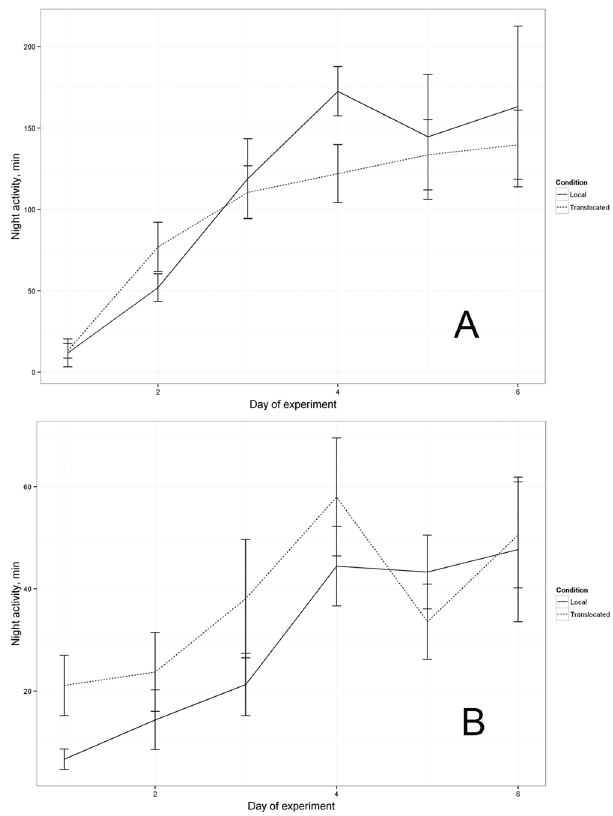
Figure 1. Development of nocturnal activity in local (solid line) vs. translocated (dotted line) birds for indoor ( A ) and outdoor ( B ) housing. The line represents a mean active period for all birds (in minutes per night) with error bars (SEM).